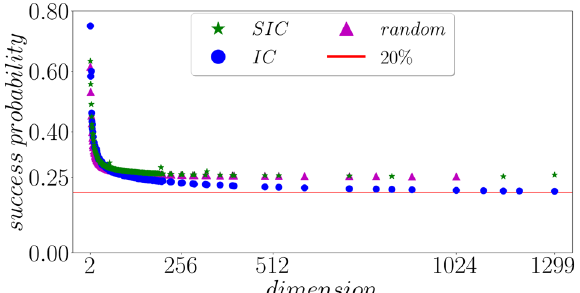
Fig. 2 Success probability q succ as a function of dimension d of the Hilbert space for d 2 -outcome measurements. Results are shown for Weyl-Heisenberg SIC-POVMs (green stars), non-symmetric IC-POVMs (blue dots), and random POVMs (magenta triangles) for dimensions upto 1299. For each dimension, we plot the maximum of q succ (computed according to the Eq. (1)), which was obtained from random ≤ 24 partitions. For random POVMs, in each dimen- sion, we generate 10 to 500 random POVMs (lower number for higher dimensions) and plot the minimum q succ across them. For IC- POVMs, the measurement operators are speci fi ed by a single parameter α which we keep at a fi xed value across all dimensions (see Section E of the Supplementary material for